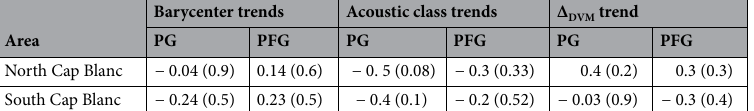
Table 2. Spearman trend tests for the barycenter displacement of pelagic abundance and Δ DVM trend (i.e., differences between day and night pelagic abundance for the plankton group (PG) and pelagic fish group (PFG)) in the areas north and south of Cap Blanc. r: Spearman correlation coefficient is shown in the first row of each cell and the p -value is shown in parentheses.